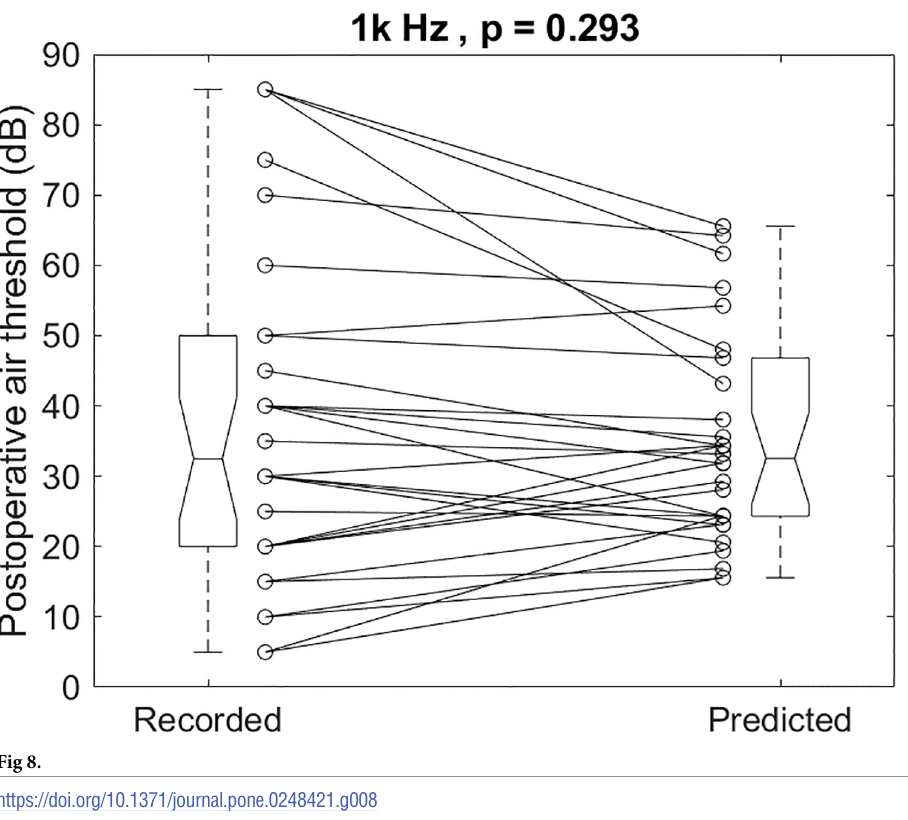
https://doi.org/10.1371/journal.pone.0248421.g008